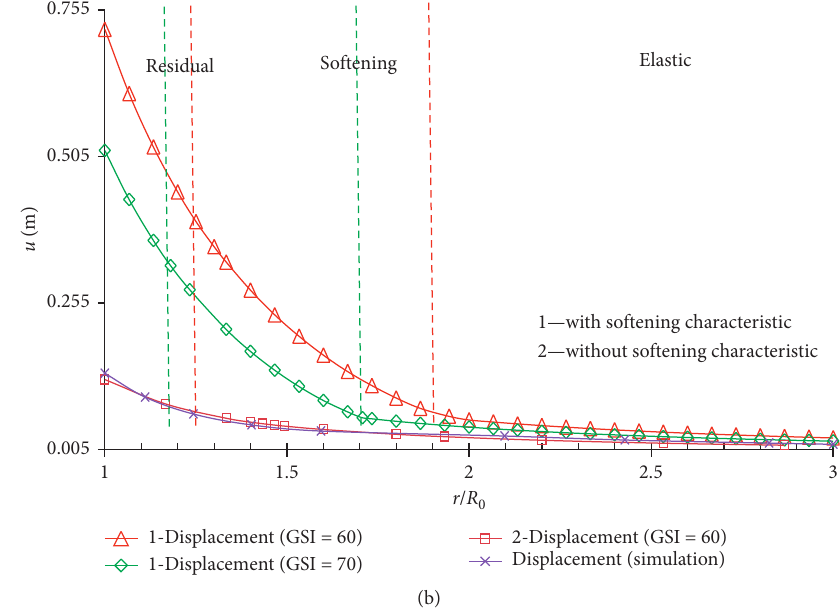
Figure 3: Validation of H-B solution against numerical results for spherical domain: (a) distributions of principal stresses; (b) distributions of displacements.